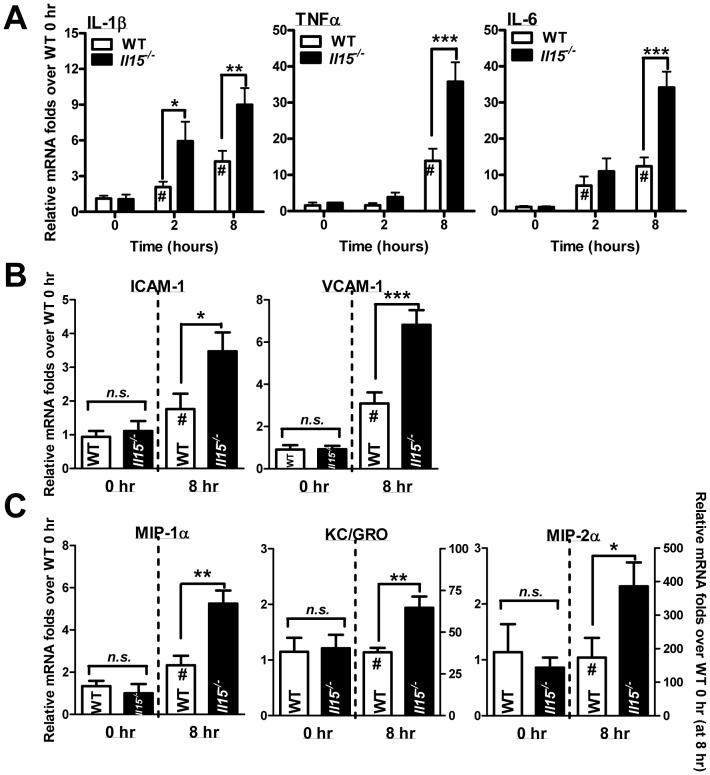
Inductions of hepatic inflammatory genes are greater in Il15−/− than WT mice with APAP challenge.Relative mRNA levels of (A) pro-inflammatory cytokines IL-1β, TNFα and IL-6; (B) vascular adhesion molecules ICAM-1 and VCAM-1; and (C) chemokines MIP-1α, KC/GRO and MIP-2α at indicated times after injection with APAP. *P<0.05; **P<0.01; ***P<0.001; #P<0.05 compared with WT at 0 hr. Data are mean ± SEM from 6∼8 mice per group.